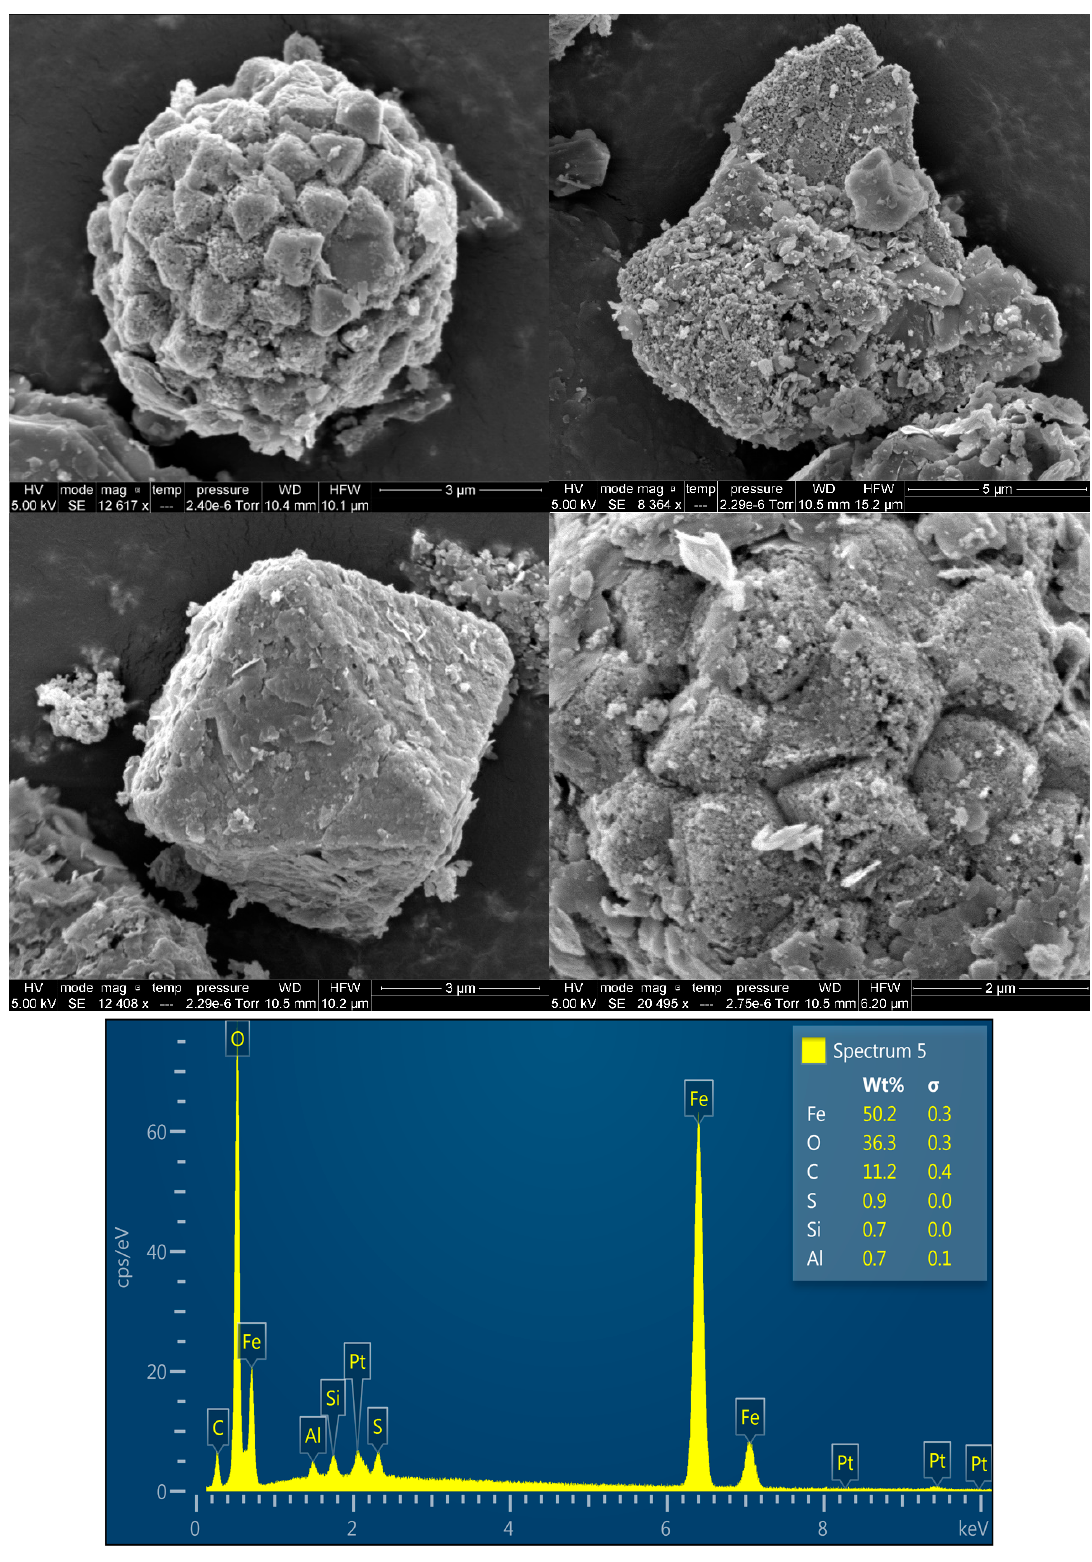
Figure 12. SEM analysis of the 2.20 SG sink fraction of Baker seam coal calcined at 400 °C and EDX analysis suggesting the formation of iron oxide and the crystal structure of pyrite being intact.